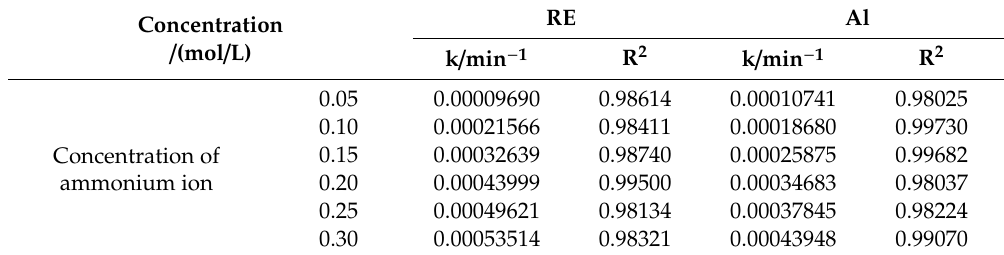
Figure 8. The fitting curve of internal di ff usion control model and time. Table 3. Apparent di ff usion rate constant and correlation coe ffi cient